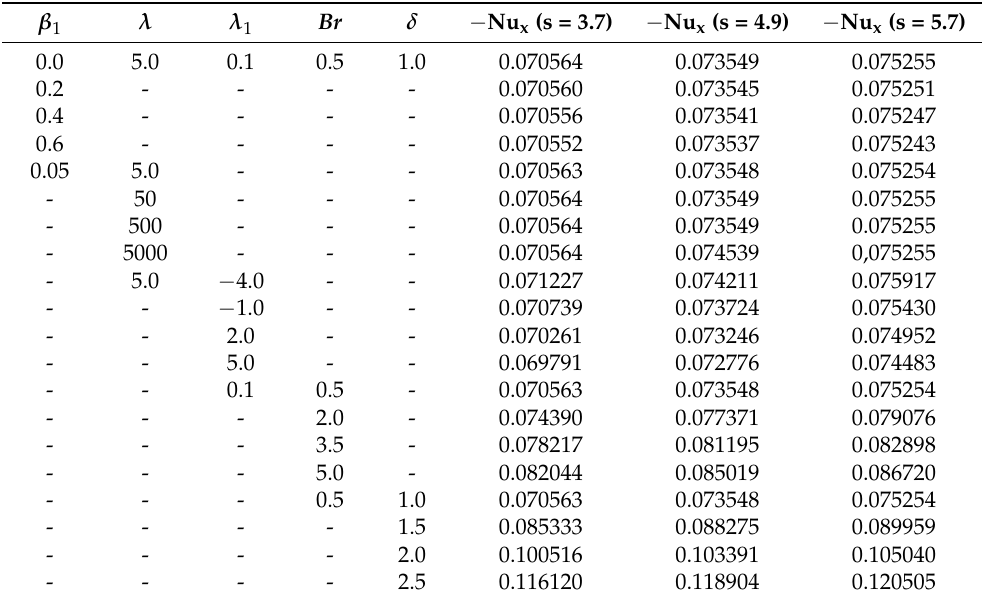
Table 4. The results for the Nusselt number of Al 2 O 3 –Ag/H 2 O against nondimensional parameters.